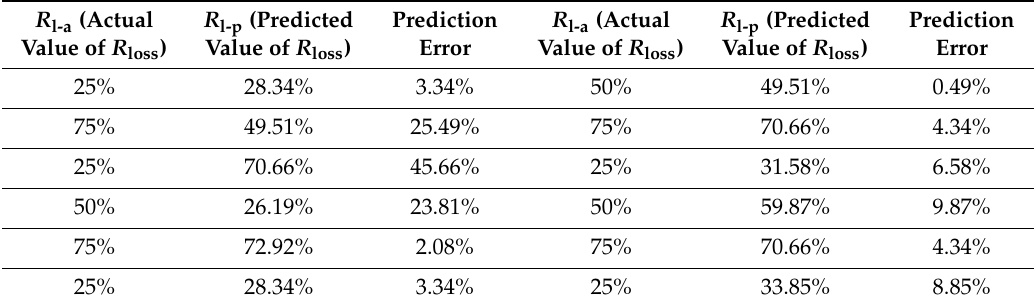
Table 12. Comparison of monitored and actual values (using the univariate t m